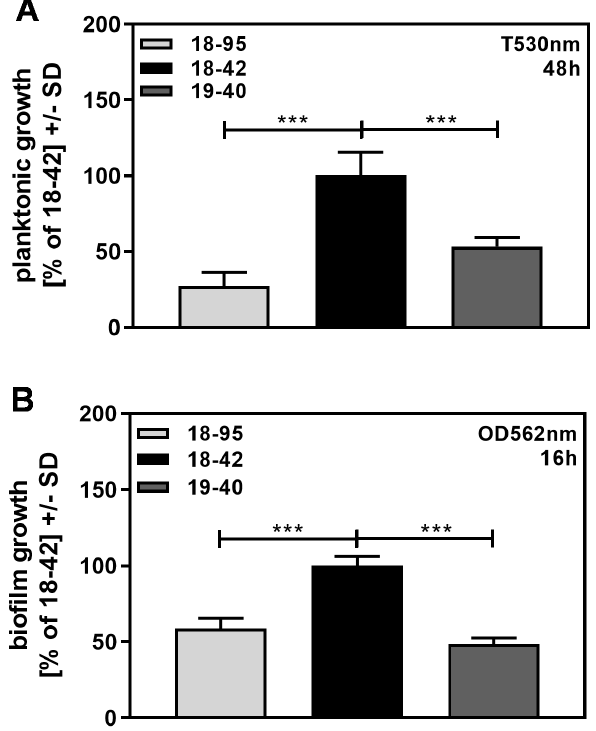
Figure 6. Virus-free A. fumigatus grows more than infected fungus. Infected (18–95, 19–40) or virus-free (18–42) Aspergillus was grown either planktonically in tubes for 48 h ( A ) or forming a biofilm in a 96-well plate for 16 h ( B ). After incubation, fungal growth was determined photometrically, as described in the Methods section. Growth of 18–42 was regarded as 100%. Comparisons: as indicated by the ends of the brackets. Statistical analysis (A, n = 6; B, n = 5): Unpaired t -test. Three asterisks = p ≤ 0.001.